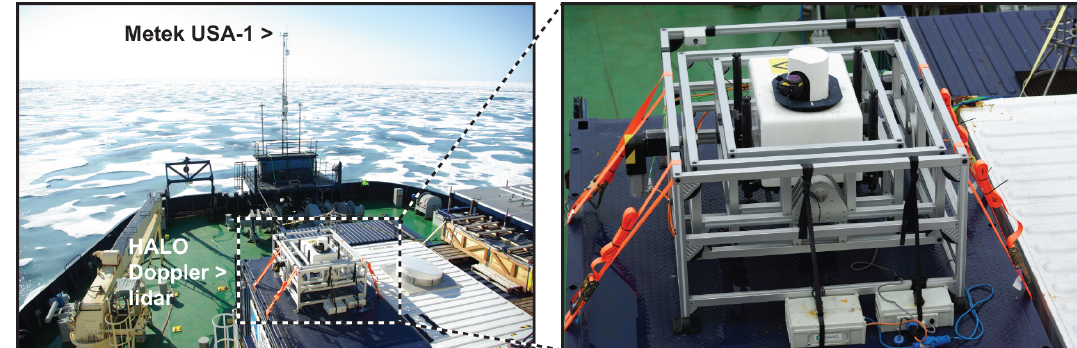
Figure 2. Oden foredeck (left) showing the lidar mounted within its motion-stabilised platform and (right) the Metek USA-1 sonic anemome- ter mounted on a mast over the bow of the ship.